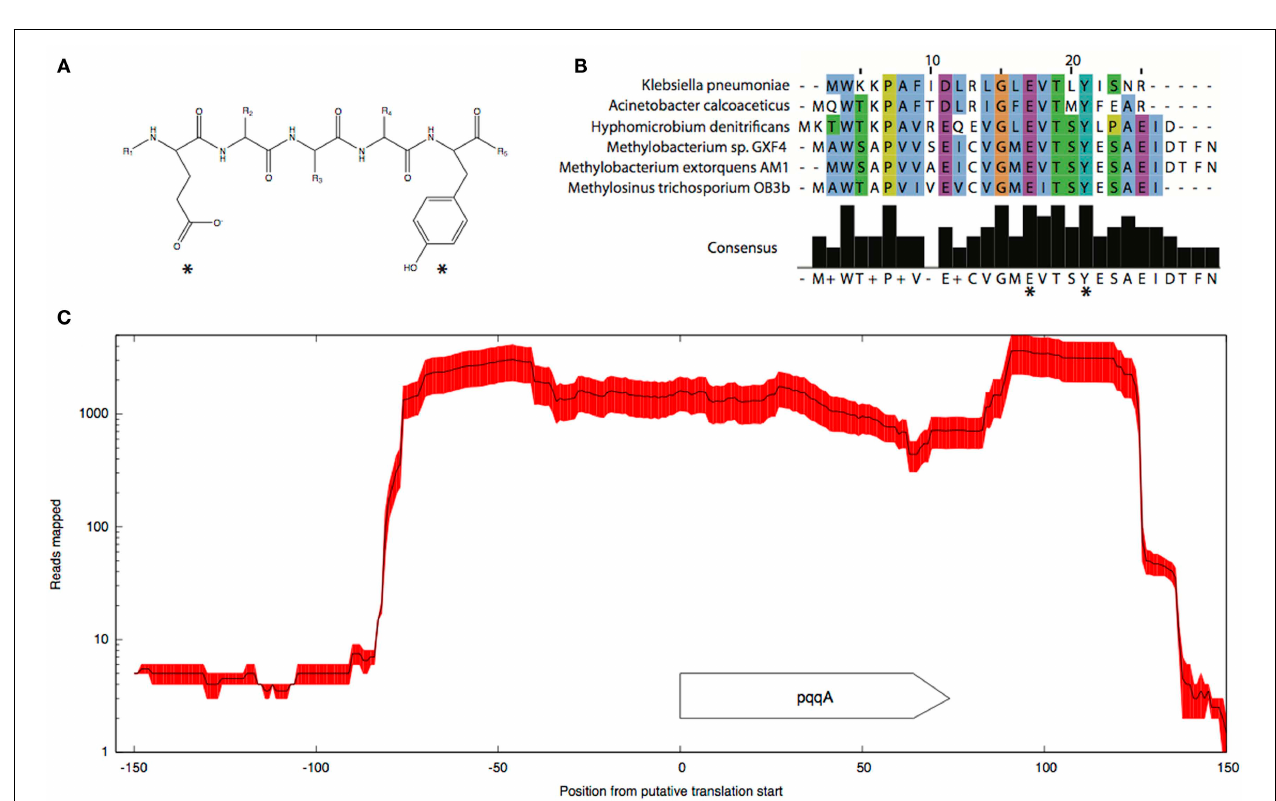
FIGURE 2 | Predicted structure (A) and alignment of the putative pqqA peptide (B) from M. trichosporium OB3b and pqqA peptides from Methylobacterium sp. GXF4, M. extorquens AM1, Hyphomicrobium denitrificans ATCC51888, K. pneumoniae , and A. calcoaceticus . (C) Mapping.